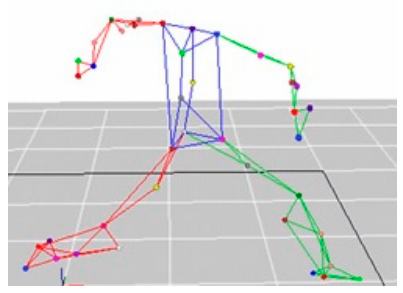
Figure 2. The Cortex software was used for markers’ three-dimensional position tracking.